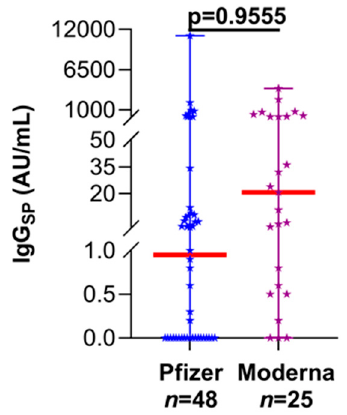
Figure 3. Evaluation of immunogenicity following the double ‐ dose Pfizer and Moderna vaccine regimen in LT recipients. Thick red line, median value; median (95% CI) (Pfizer—0.9 (0.0–4.1); Moderna—20.6 (0.8–80.2)).